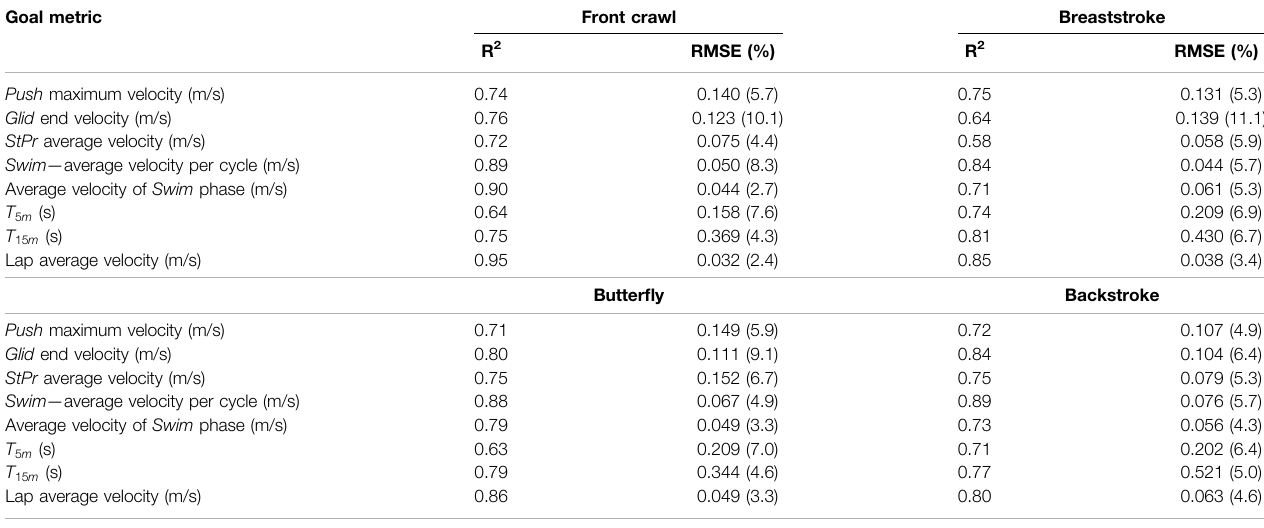
TABLE 3 | The results of evaluating LASSO regression for goal metrics estimation. The determination coef fi cient (R 2 ) and root mean square of error (RMSE) and the relative RMSE (in %) of regression are reported for each swimming technique. Goal metric Front crawl Breaststroke